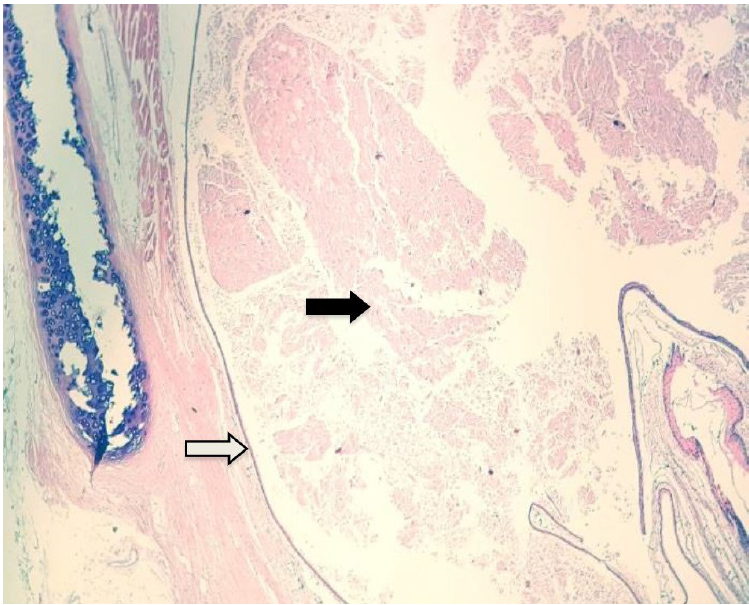
Figura 6. Fotomicrografia de cisto epidermóide em laringe. Lesão cística revestida por epitélio escamoso (seta branca) contendo aglomerados de queratina (seta preta). Hematoxilina e eosina. Objetiva de 04X. Fonte: